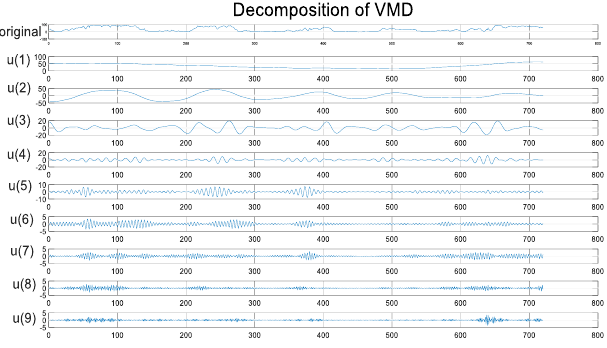
Figure 7. Decomposition of VMD.